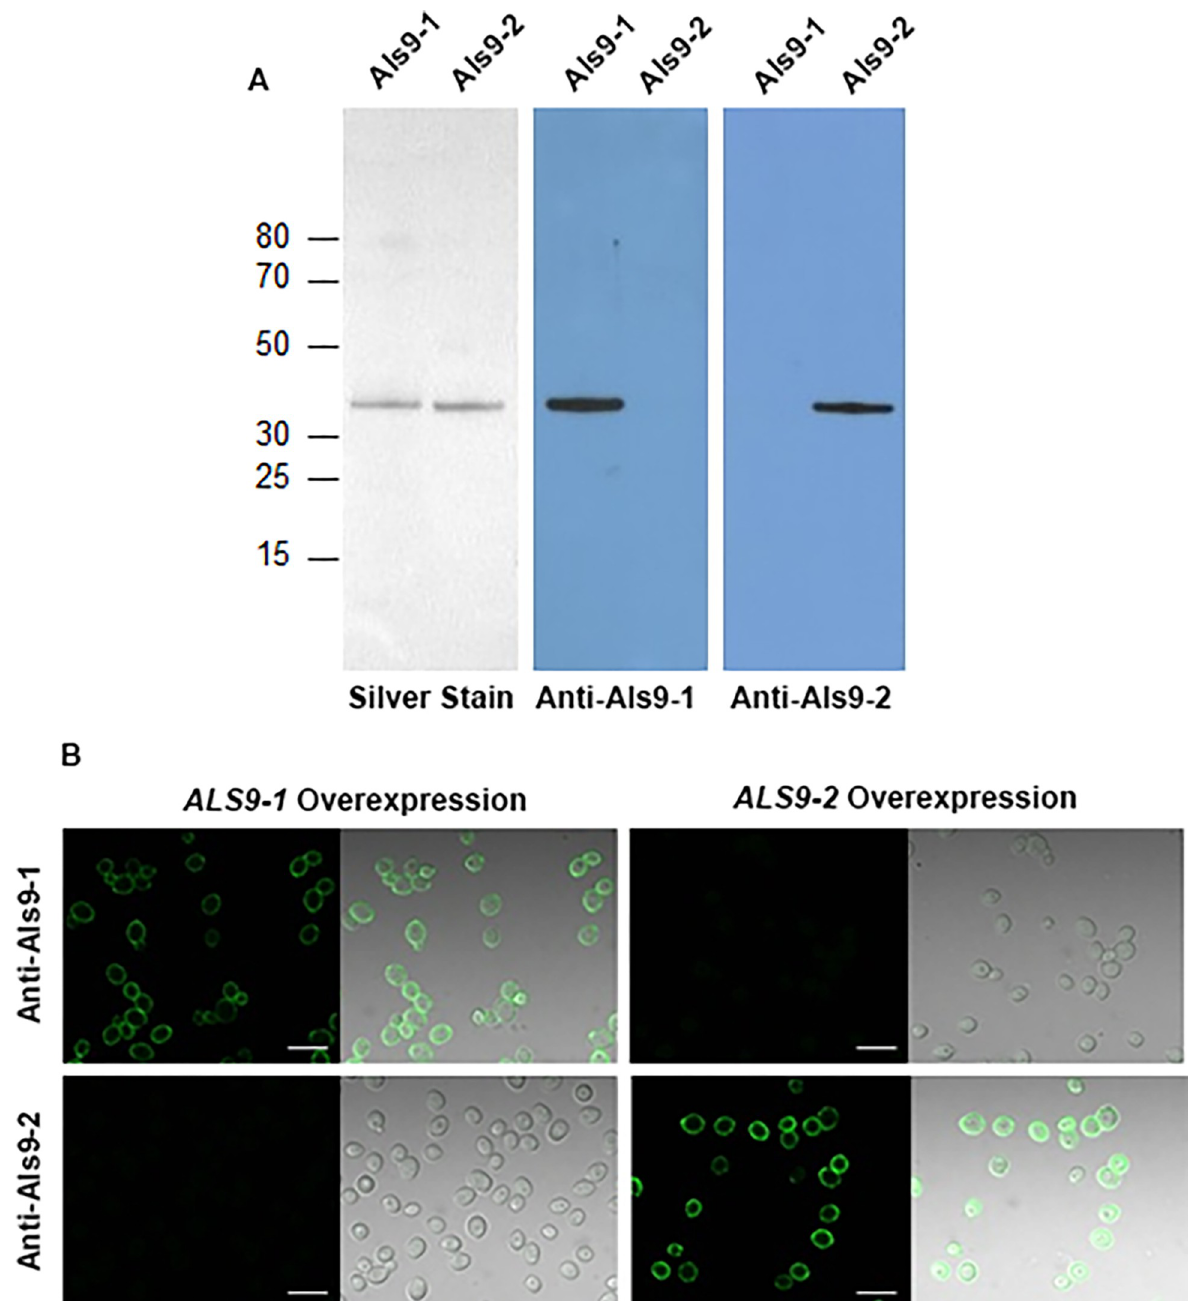
Fig 1. Specificity of anti-Als9-1 and anti-Als9-2 for their respective proteins. (A) Western blotting of purified NT domain fragments (amino acids 18 to 328 for each) from Als9-1 and Als9-2. The silver-stained polyacrylamide gel validated equal loading for the proteins (left panel). Western blots (middle and right panels) of identical sets of lanes were also prepared and exhibited specificity of each MAb for its antigen. (B) Immunolabeling of ALS9 overexpression strains with anti-Als9-1 MAb 9-C4 or anti-Als9-2 MAb 9-A7. Immunolabeling did not produce visible signals for wild-type C . albicans so overexpression strains were constructed. Each produced protein under control of the constitutive TPI1 promoter. Labeling only of cells that expressed the allele used to produce the antigen further validated specificity of the anti-Als9 MAbs. Endo H treatment of the ALS9-2 overexpression cells was required to see a positive immunolabeling signal with MAb 9-A7. The ALS9-1 overexpression strain did not require EndoH treatment to see its positive signal after immunolabeling with anti-Als9-1 MAb 9-C4. Scale bars in each figure = 10 μ m.